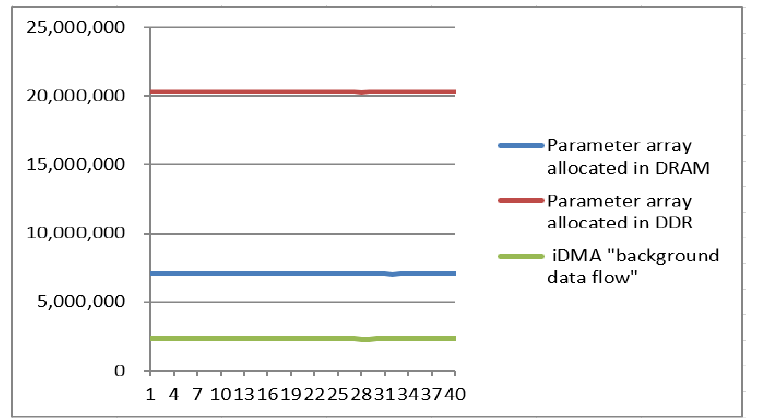
Figure 12. Cycle statistics, whereby the horizontal coordinate represents the video sequence and the vertical coordinate represents the number of cycles that were consumed.